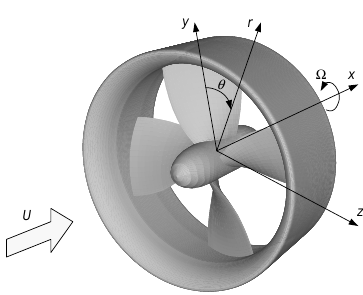
Figure 2. Propeller coordinate